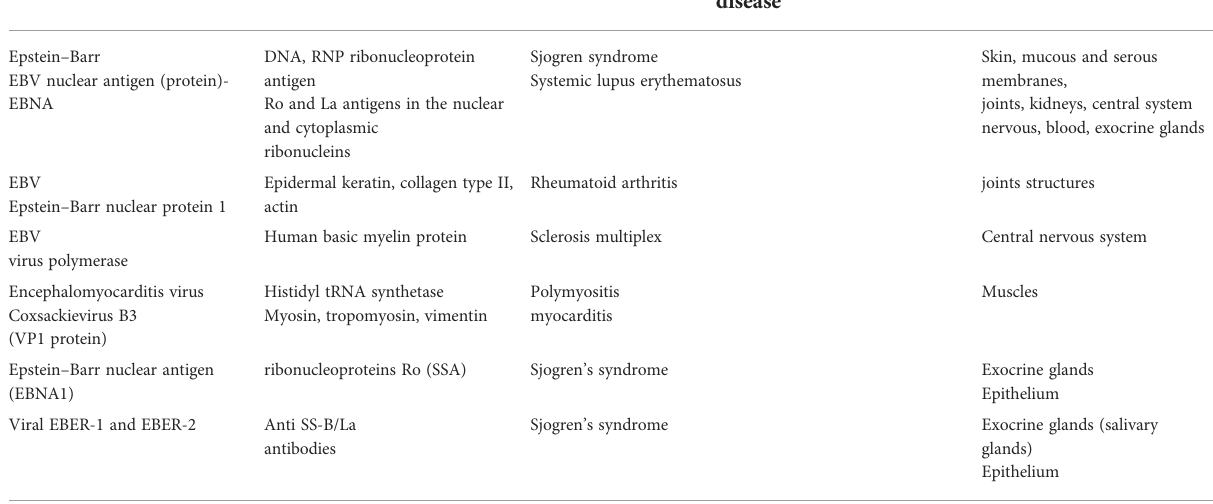
TABLE 2 Examples of molecular mimicry between viral and human antigens (31 – 33)